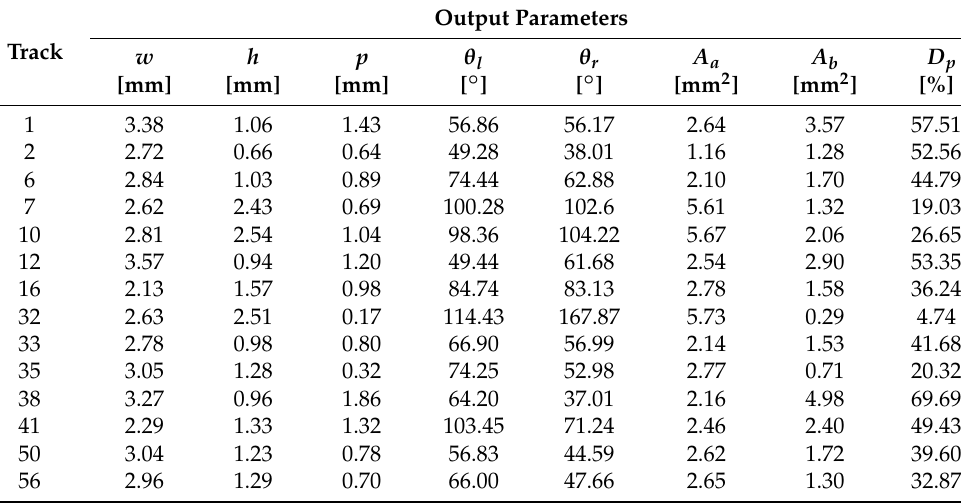
Table 5. Output parameters computed through the developed algorithm.